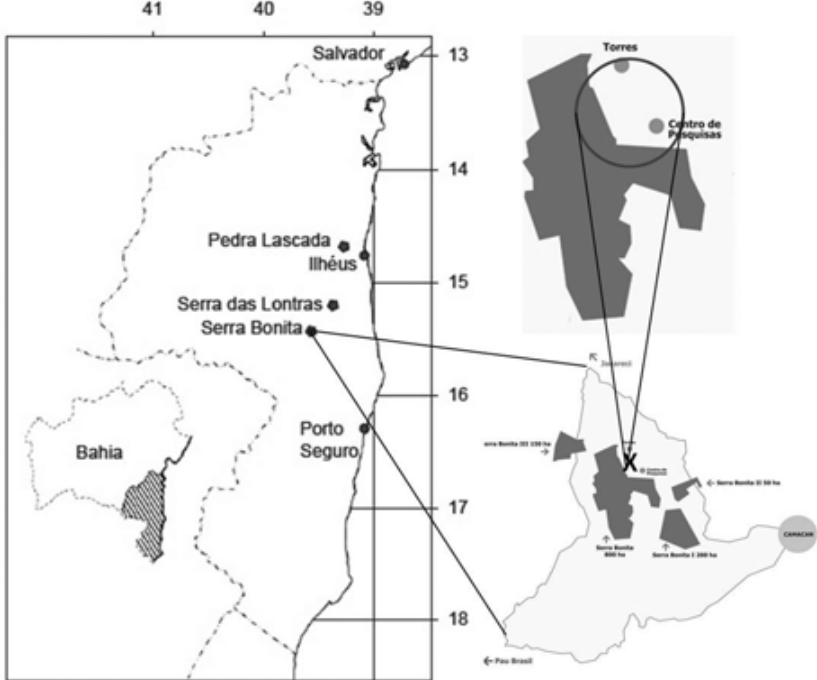
Fig. 1. Localization map: Serra Bonita RPPN, State of Bahia,